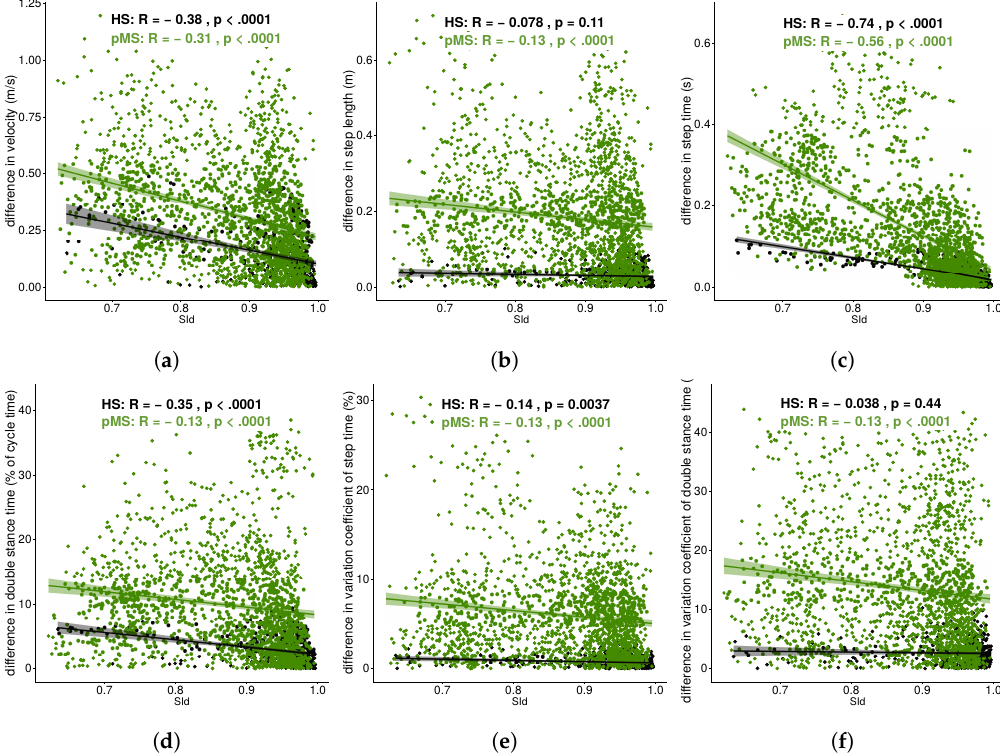
Figure 6. Correlation of SId to conventional features: ( a ) Average walking velocity; ( b ) step length; ( c ) step time; ( d ) double stance; ( e ) coefficient of variation of step time; ( f ) coefficient of variation of double stance time.